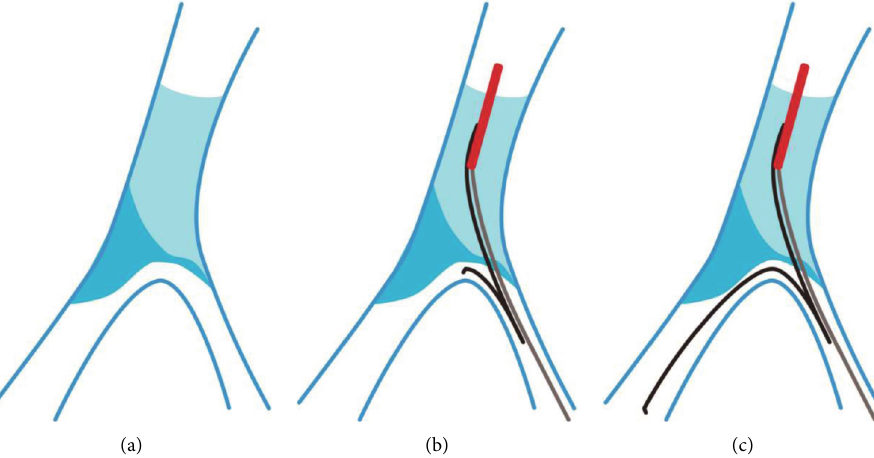
Figure 1: Antegrade recanalization of CTO by ARW included three steps as follows: (1) after the wire accessed the branch, angiography through microcatheter was conducted to distinguish true lumen from false lumen; (2) a double cavity microcatheter and a hydrophilic- coated wire ((a) 90 ° shaping at 1mm to the headend; (b) reflexed shaping at 2-3cm to the headend) were concurrently delivered, and a small balloon could also be used to dilate the access with low pressure (avoiding changing the structures of the bifurcation) (b); and (3) withdrawal of the double cavity microcatheter, while the wire was adjusted to access the true lumen of the segment distal to the occlusion